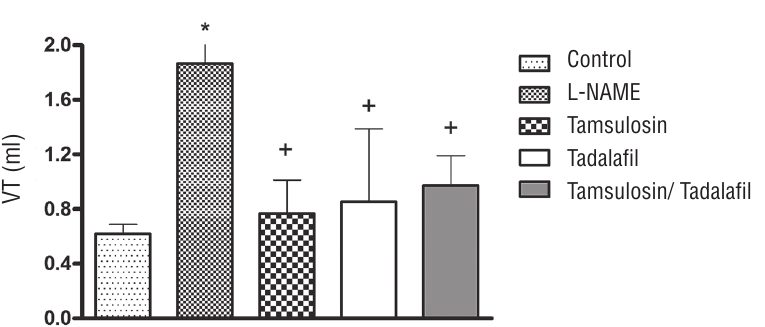
-arginine methyl ester (L-NAME) incresed volume thrshold (VT); co-treatment Figure 2 - Long term administration of N ω -nitro- L with tamsulosin, tadalafil, and the combination of Tamsulosin/Tadalafil reduce VT.